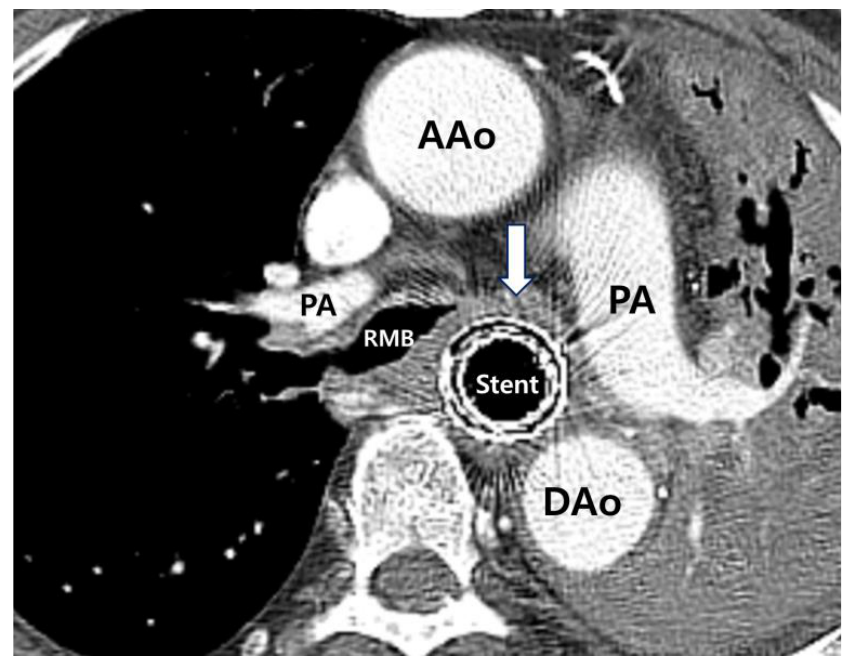
stent at the site of tracheal bifurcation. LMB, left main bronchus; RMB, right main bronchus .